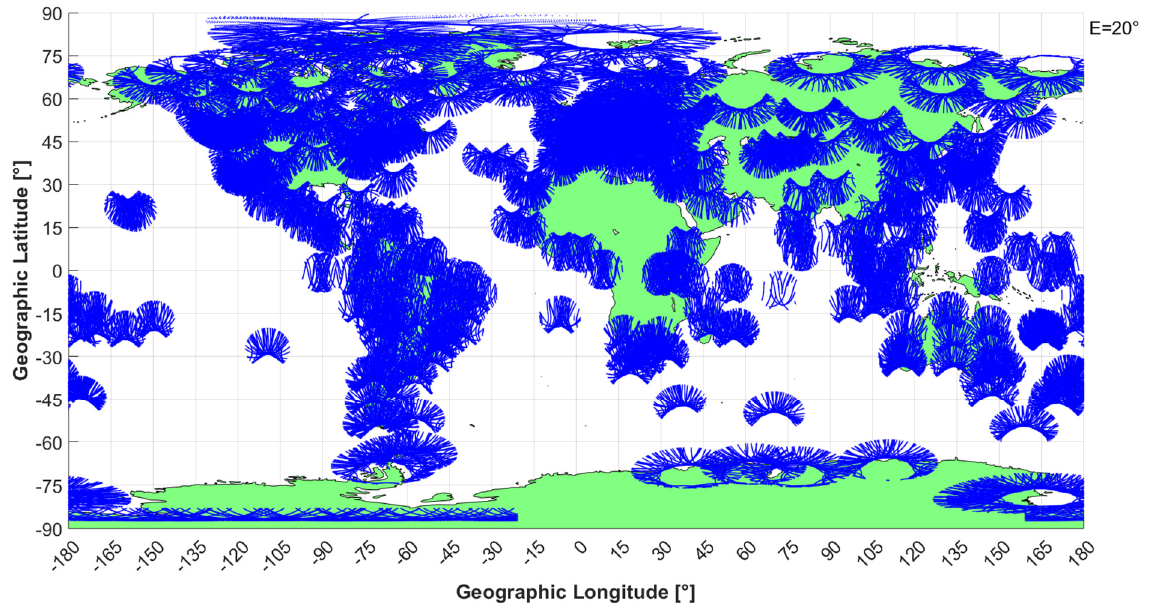
Figure 12. The footprint tracking of satellites at all 483 IGS stations on 26 March 2015. As can be seen, the density of IGS stations is not uniform globally. In addition to the ocean regions without any GNSS stations, in some land areas, the number of IGS stations is also very sparse, particularly in Africa, the Russian Federation, Antarctica, and China. The density of IGS stations is highest in Western Europe, North America, and South America, and somewhat in the Pacific Islands, Australia, and East Asia.